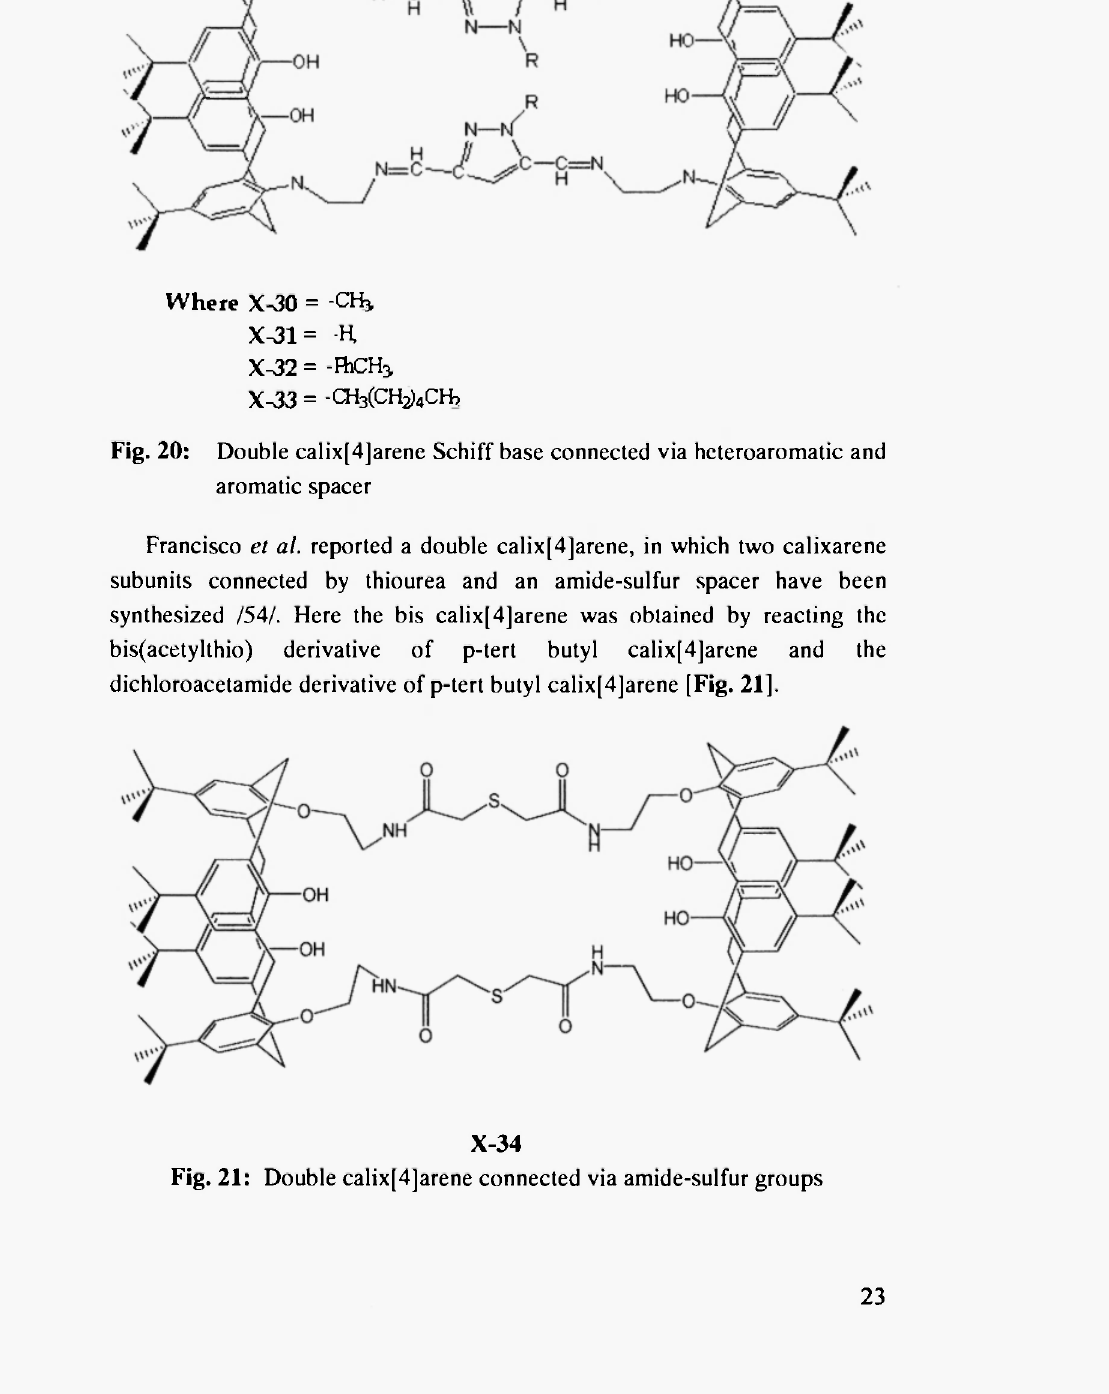
Fig. 20: Double calix[4]arene Schiff base connected via hcteroaromatic and aromatic spacer